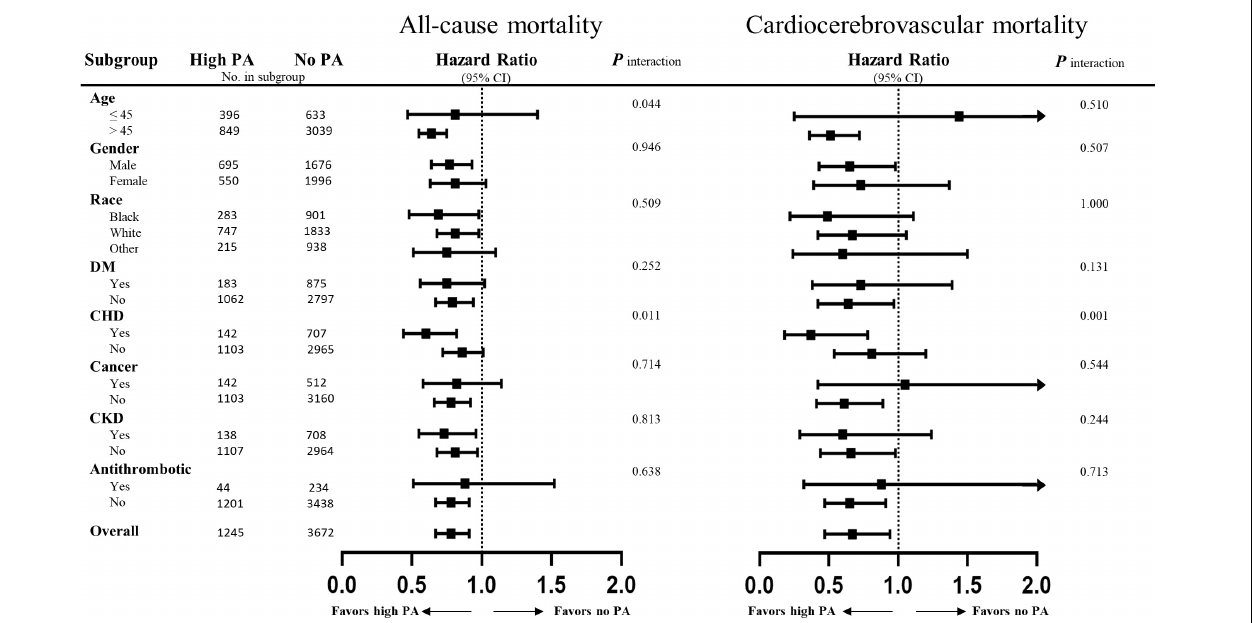
Physical activity, MET-h/week